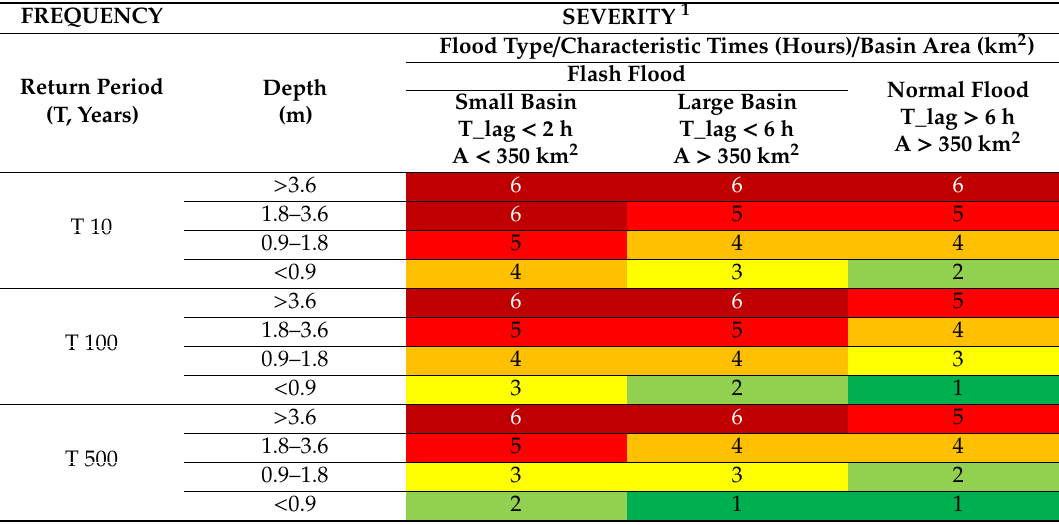
Table 1. Flood hazard matrix for cultural heritage